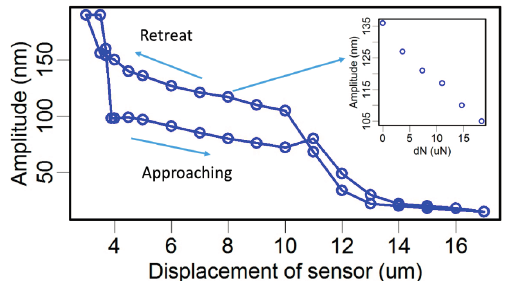
Figure 17. The frictional interaction between the silica–silica surfaces with varying normal pressures.